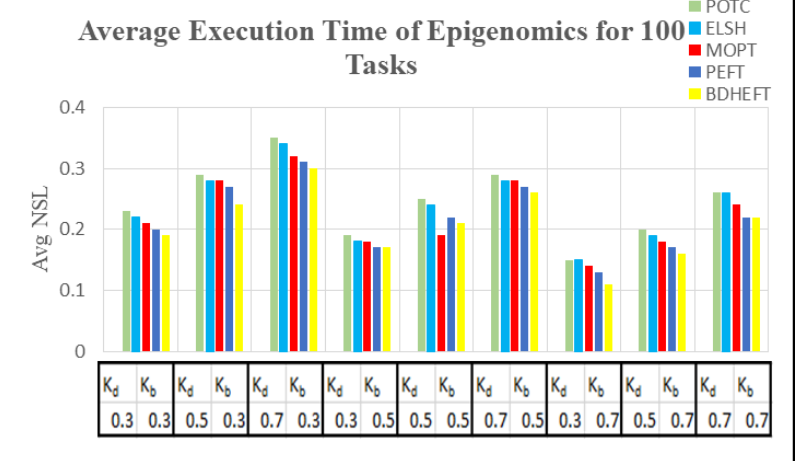
Figure 12. Average execution time of the epigenomics workflow for different deadline factors.